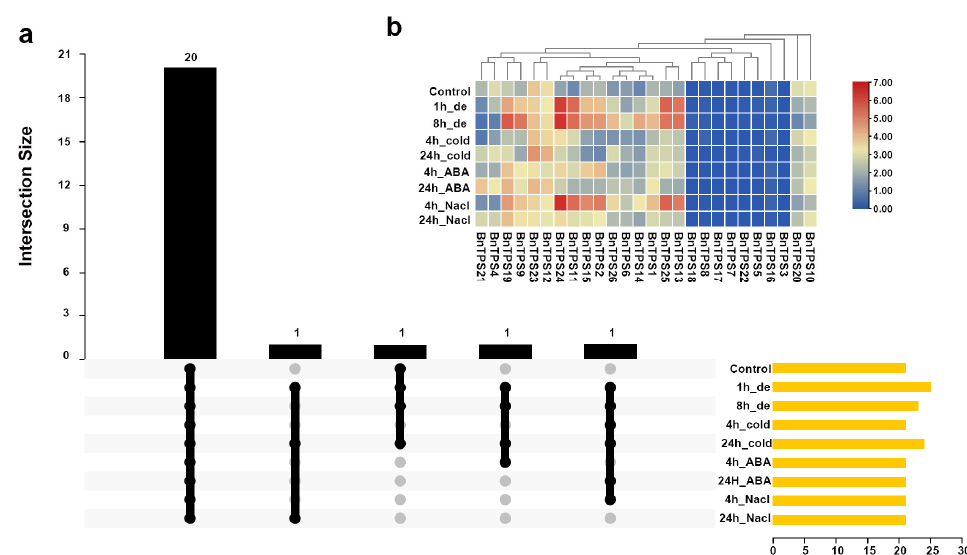
Figure 7. Expression profiles of BnTPS genes under different abiotic stress conditions. ( a ) The numbers of BnTPS genes that were expressed under different abiotic stress conditions. ( b ) Heatmap representation of 26 BnTPS genes under different abiotic stresses. Log2 normalization was used to process the expression data. From low (blue color) to high (red color), the color scale represents relative expression levels. The ‘de’ represents dehydration.